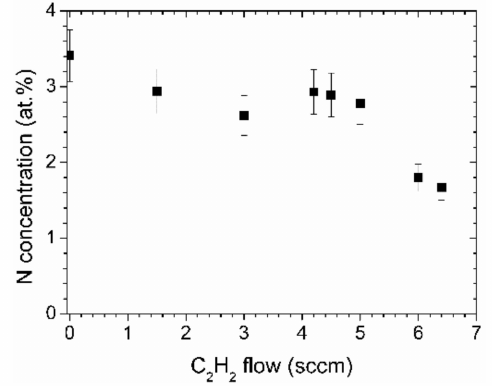
Figure 3. Nitrogen concentrations of the N-DLC films as determined by X-ray photoelectron spectroscopy (XPS).